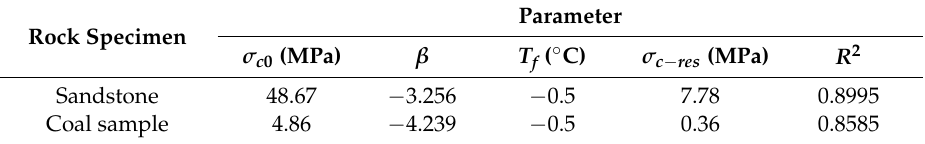
Figure 4. Uniaxial-compression strengths of sandstones and coal samples as a function of temperature.